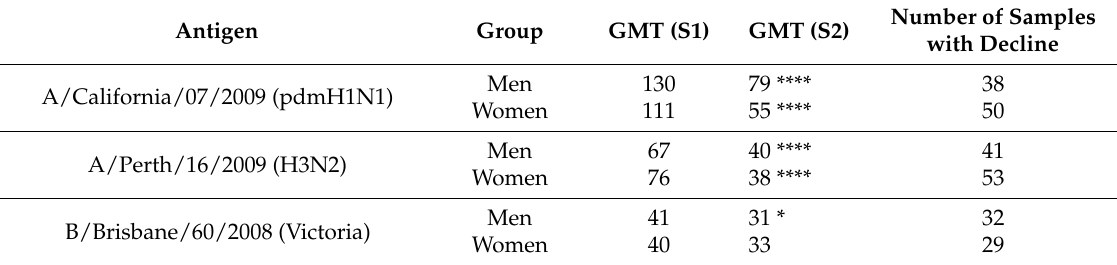
Number of Samples with Decline